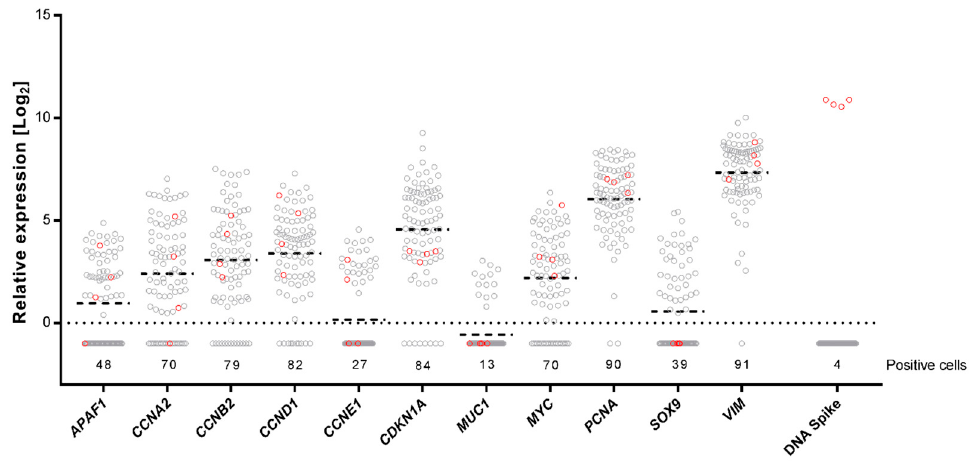
Figure 4. Single-cell gene expression profiling, where 92 single cells were treated with Cod uracil-DNA N-glycosylase (Cod UNG) in presence of 100 copies of an artificial uracil-containing DNA spike followed by preamplification using dUTP. The relative expression is shown for each gene where individual cells are represented by circles. The number of cells expressing each gene is indicated. Horizontal bars indicate mean expressions; the dotted line indicates one molecule. Four of the 92 cells were treated with heat inactivated Cod UNG (red), while the remaining 88 cells were treated with active Cod UNG (grey).